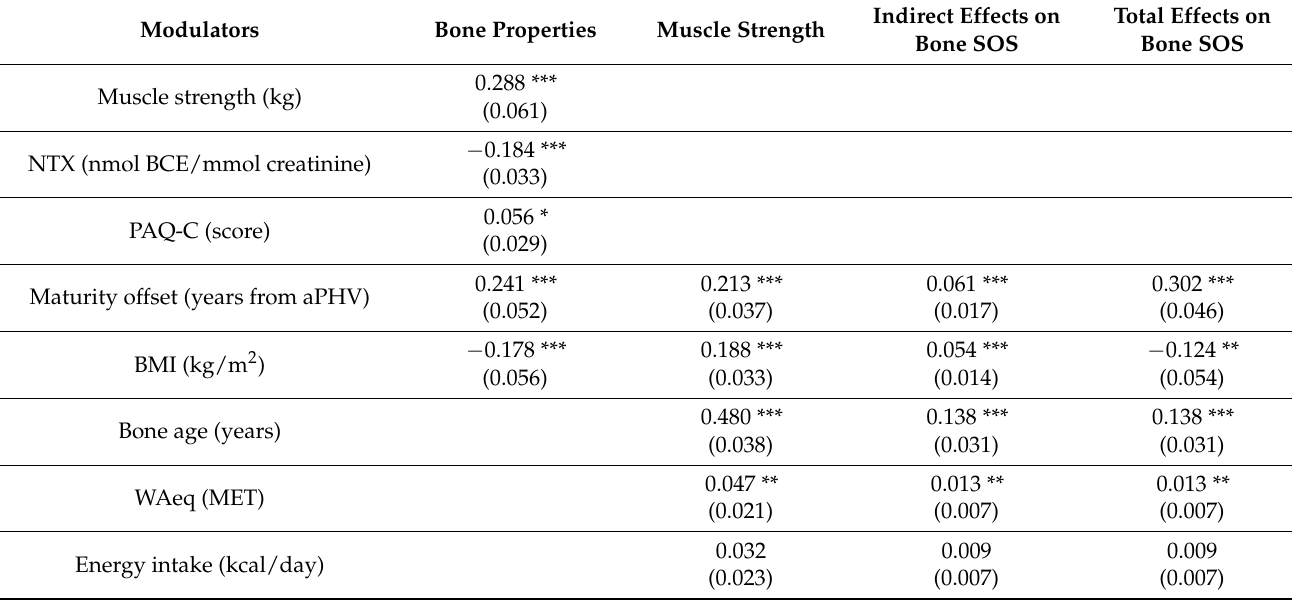
Table 2. Functional model of bone development results (total cohort). Values are β -coefficients with standard errors in